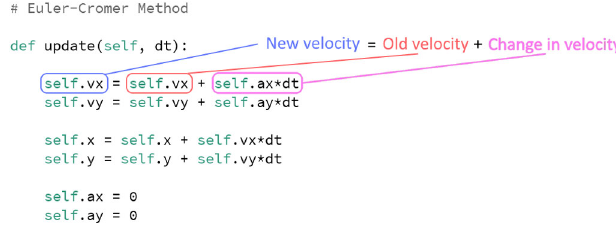
FIG. 2. The update() function of the particle class uses the Euler-Cromer method for integration. The connection between position, velocity, and acceleration becomes explicit when implemented into code. Velocity is used as the “ changer of position during a timestep ” and acceleration is used as the “ changer of velocity during a timestep. ” The acceleration is calculated in a separate function, applyForce(), which extracts the acceleration from all the forces a particle experiences. The acceleration is reset between each timestep to avoid an “ impetus- like ”